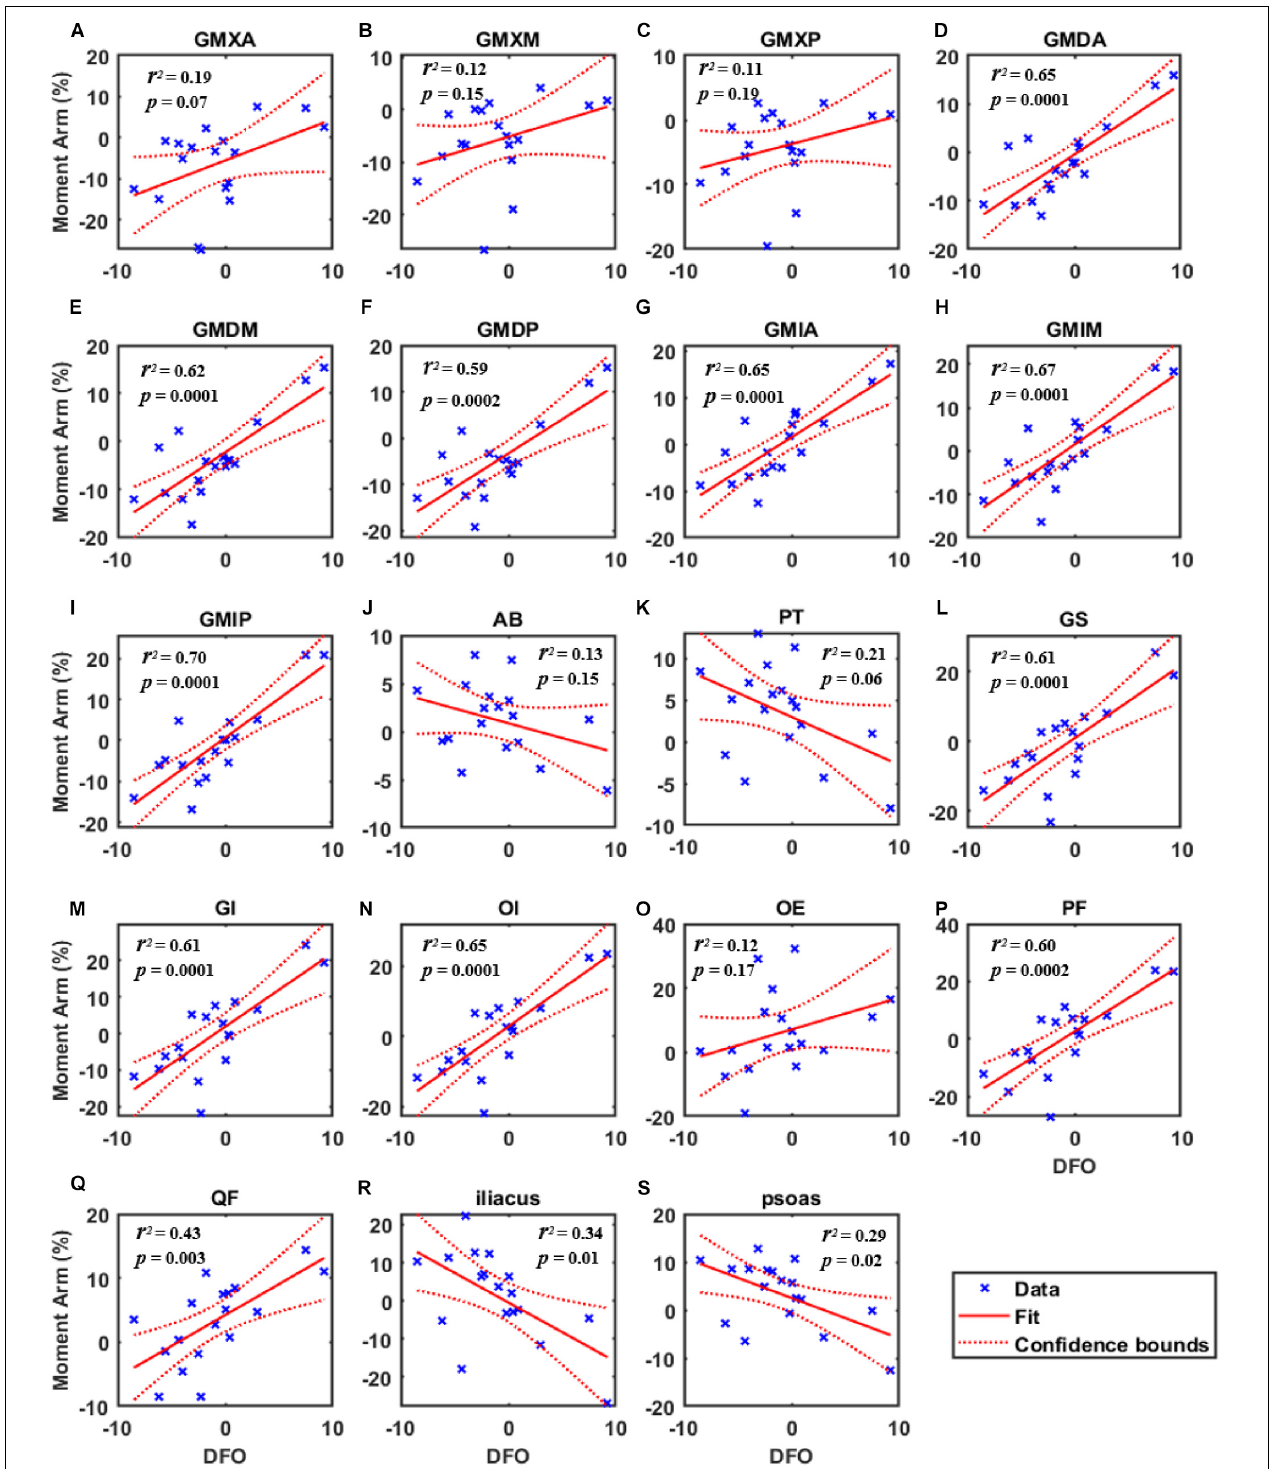
FIGURE 4 | The simple linear regression curve showed the highest correlations of the moment arm change ratio [Moment Arm (%)] with the FO difference (DFO) during gait. (A) Gluteus maximus anterior bundle (GMXA), (B) gluteus maximus median bundle (GMXM), (C) gluteus maximus posterior bundle (GMXP), (D) gluteus medius anterior bundle (GMDA), (E) gluteus medius median bundle (GMDM), (F) gluteus medius posterior bundle (GMDP), (G) gluteus minimus anterior bundle (GMIA), (H) gluteus minimus median bundle (GMIM), (I) gluteus minimus posterior bundle (GMIP), (J) adductor brevis (AB), (K) pectineus (PT), (L) gemellus superior (GS), (M) gemellus inferior (GI), (N) obturator internus (OI), (O) obturator externus (OE), (P) piriformis (PF), (Q) quadratus femoris (QF), (R) (iliacus), and (S) psoas. The saltire represented the data of one subject during gait. p : significant level, r 2 : coefficient of determination.